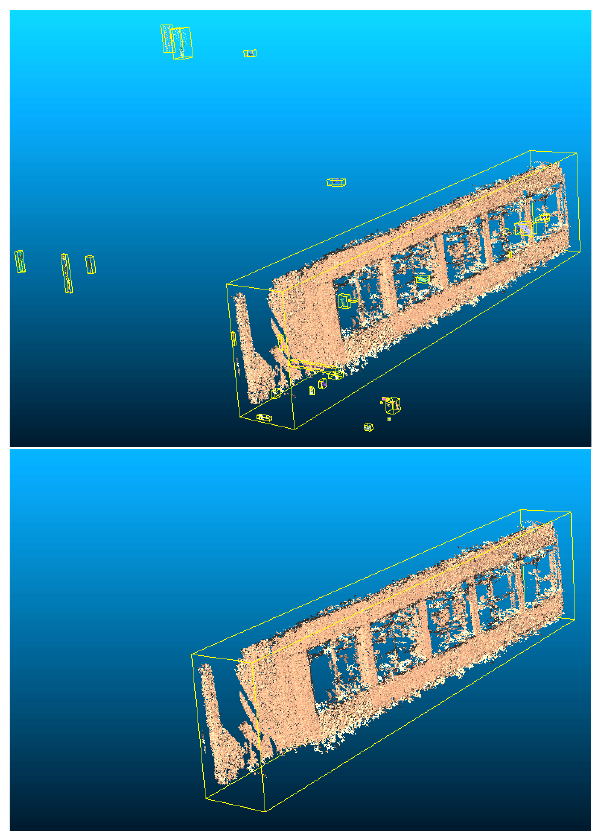
Figure 8: Top; segments obtained by connected component anal- ysis. Bottom; Largest segment is selected as the object of interest and the other segments are removed.